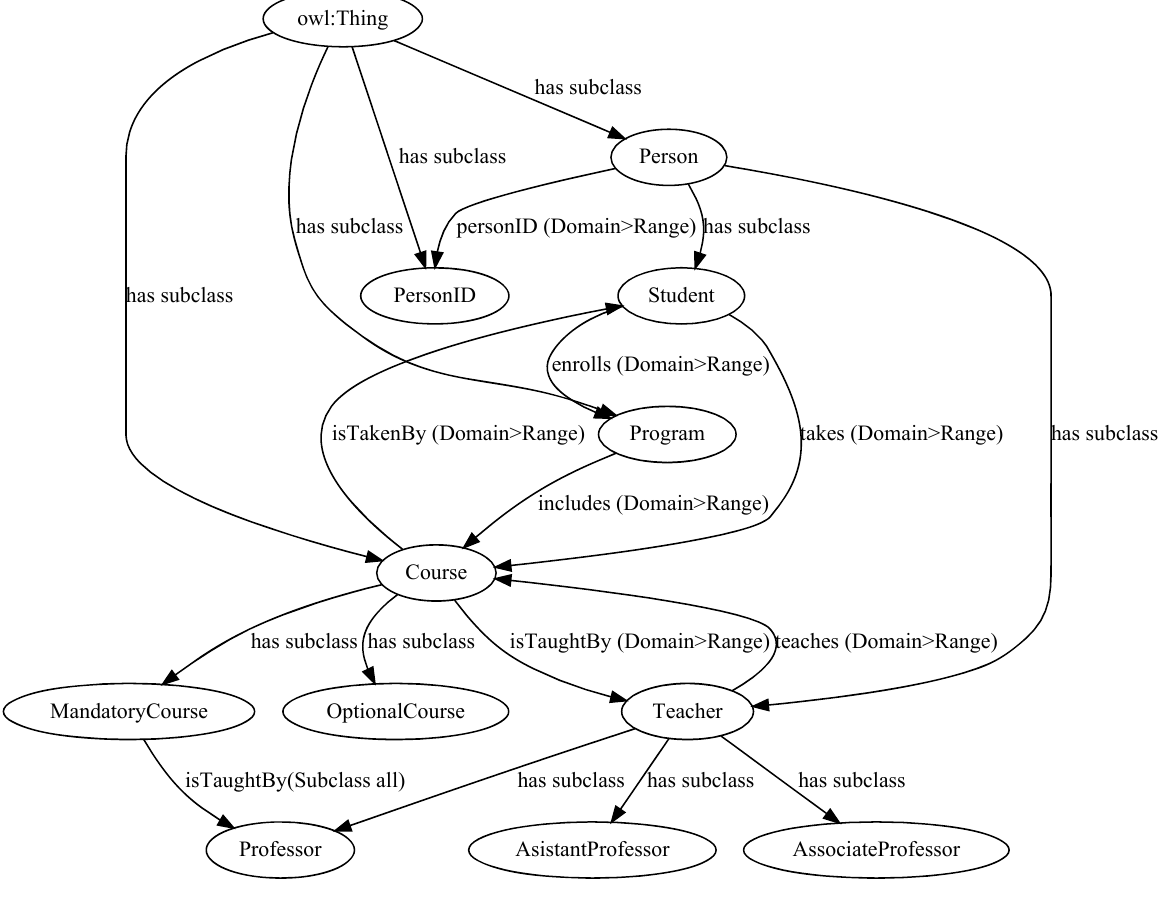
Figure 5. Example ontology of Mini University data